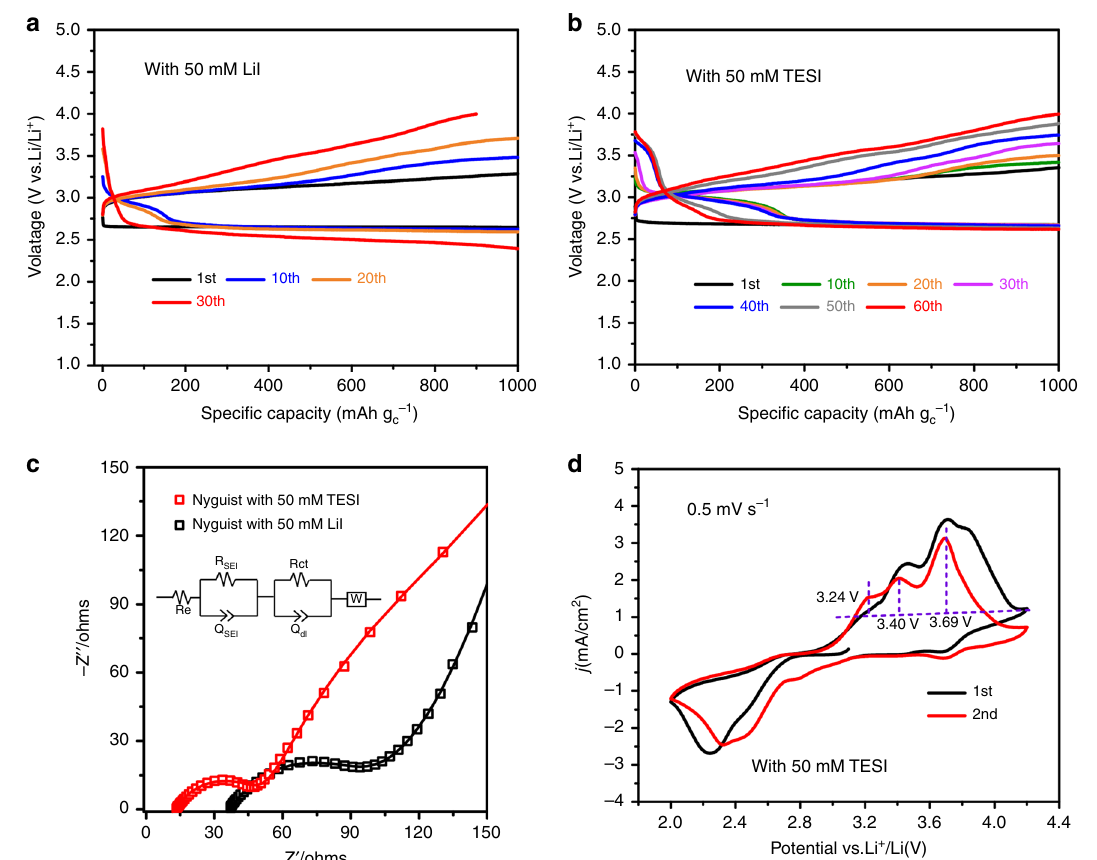
Fig. 3 Electrochemical performance of the Li-O 2 cells with TESI or LiI at a limited speci fi c capacity of 1000mAh g − 1 . a With 50mM LiI additive for 30 cycles, current density: 500mAg − 1 . b With 50mM TESI additive for 60 cycles, current density: 500mAg − 1 . c EIS of the Li-O 2 cell after 30 cycles with 50mM TESI or 50mM LiI and EIS analysis using an equivalent circuit model (shown in the inset). d Cyclic voltammograms (CV) of the TESI-containing Li-O 2